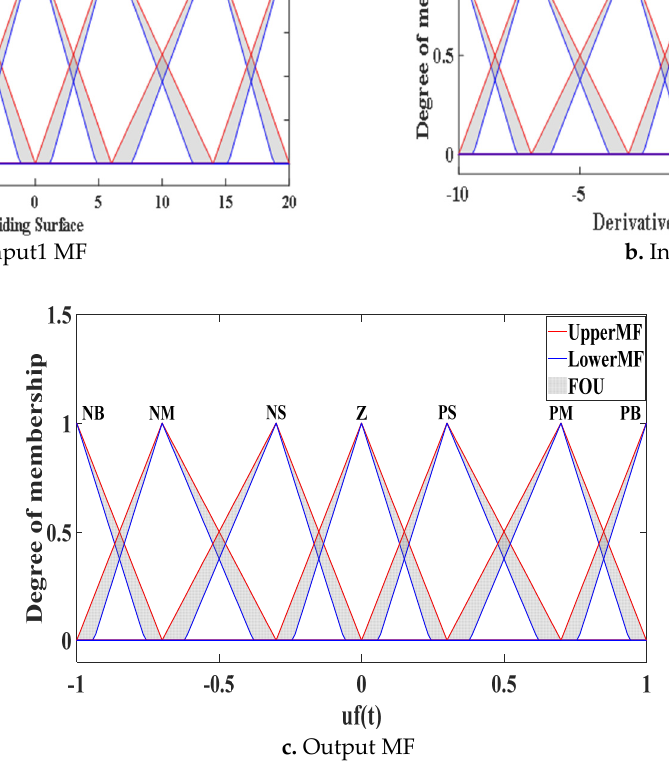
Figure 6. T2F − SFOSMC parameters.